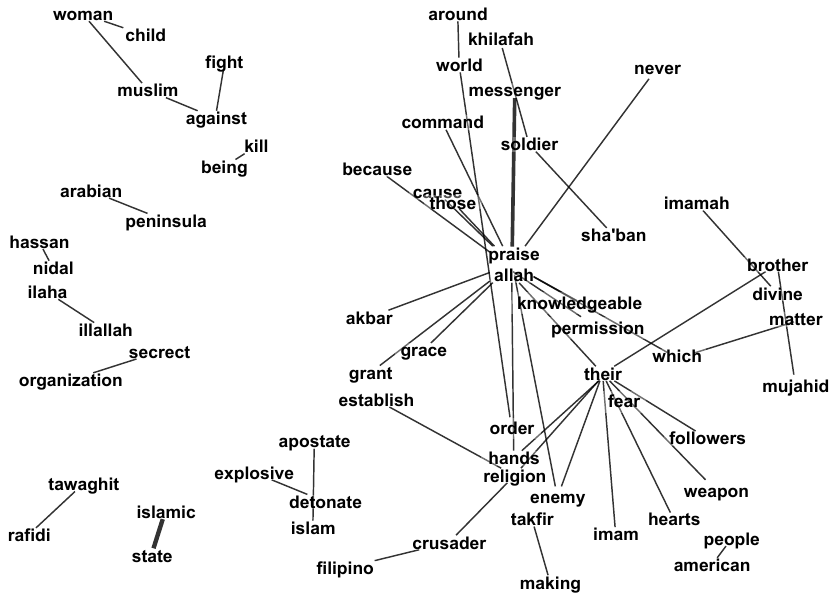
Figure 8. Word co-occurrence network discovered in the dataset which was defined in Section 4.1.